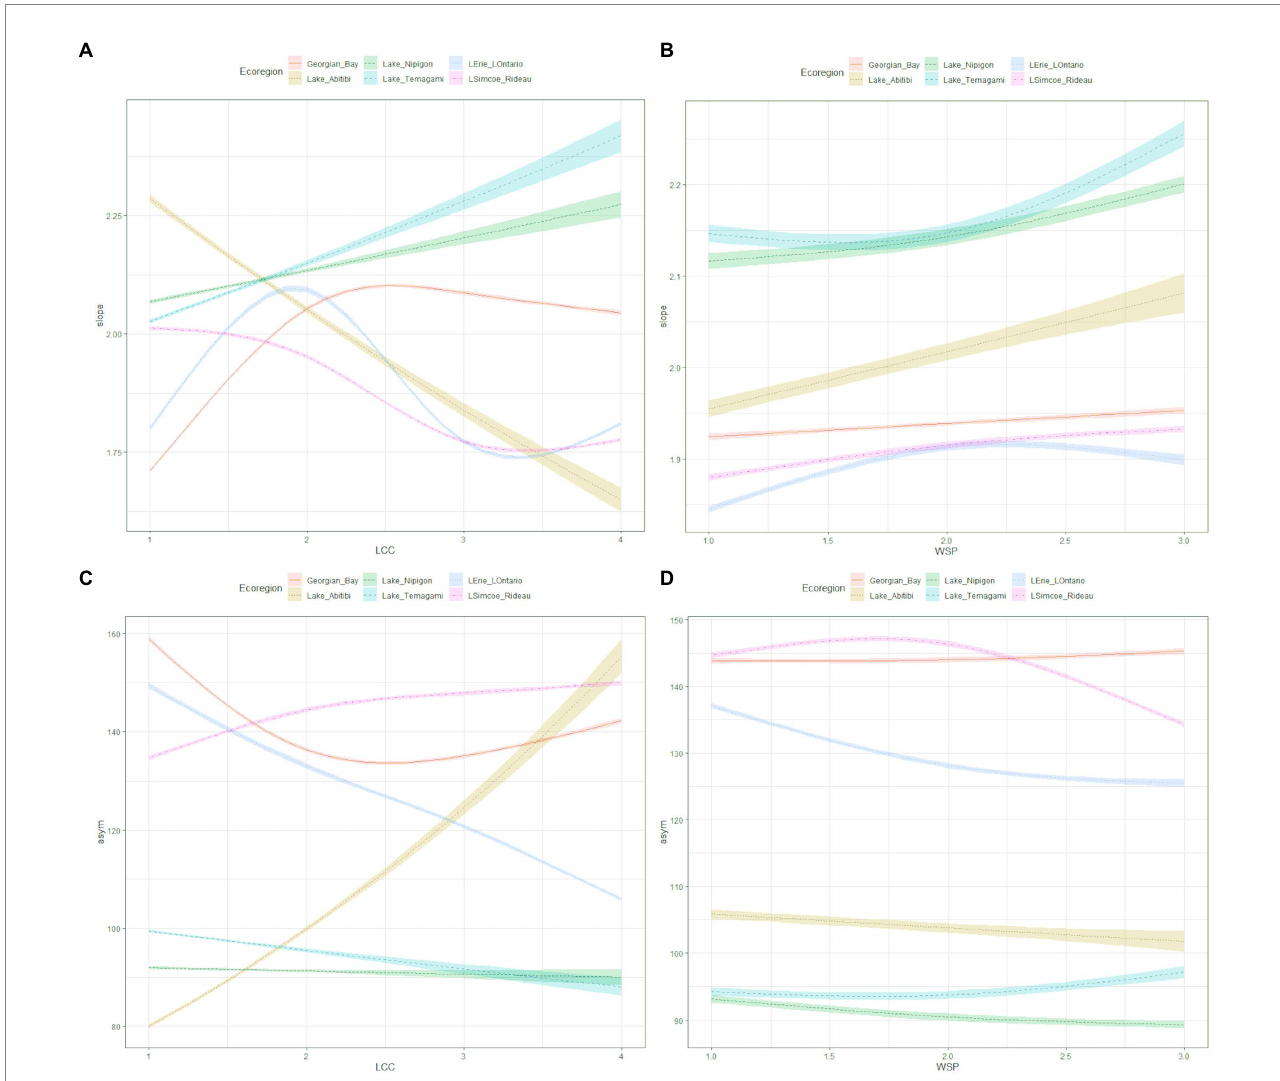
FIGURE 6 Results of GAM showing: (A) the slope in relation to Ecoregion and landcover class interacting; (B) the slope in relation to Ecoregion and watershed position interacting; (C) asymptote in relation to the interaction between Ecoregion and landcover class; (D) asymptote in relation to the interaction between Ecoregion and watershed position. Predictor variables were converted to a logit binary classification with Forest = 1, Greenspace = 2, Agricultural = 3, and Urban = 4. This was also done with WSP where HW = 1, MW = 2 and OUT =